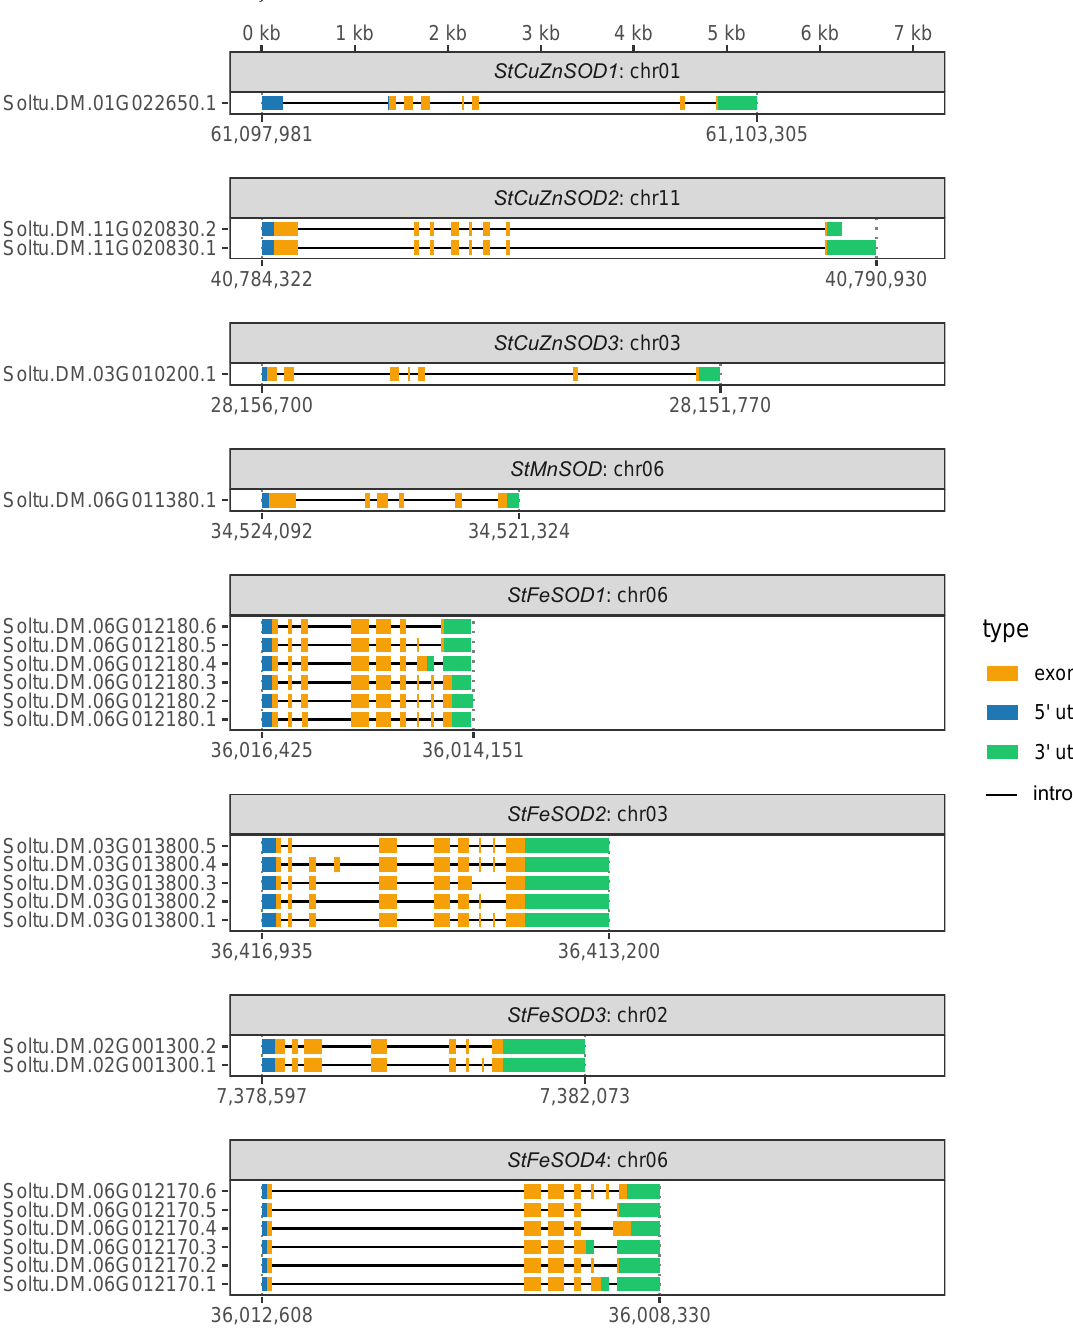
Figure 1. Exon-intron organization of StSOD genes. The blue and green rectangles represent UTR, the orange rectangle represent exons, and black lines represent